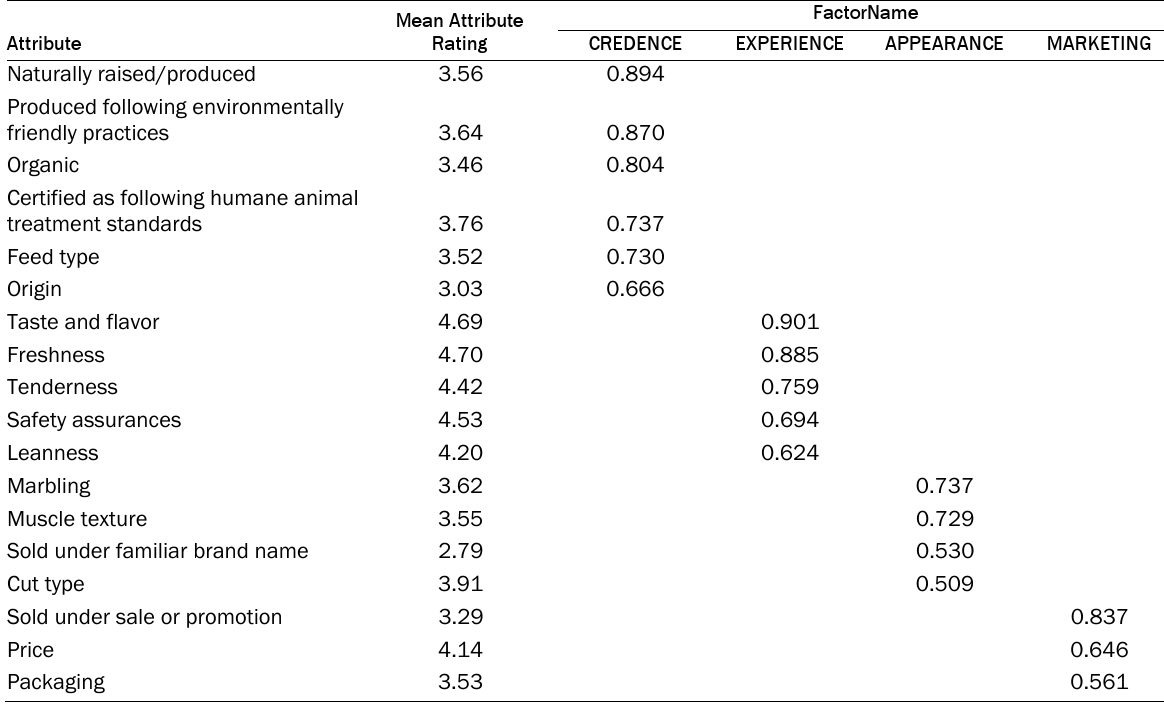
Table 1: Attribute Ratings and Factor Analysis Results (ratings on a 1–5